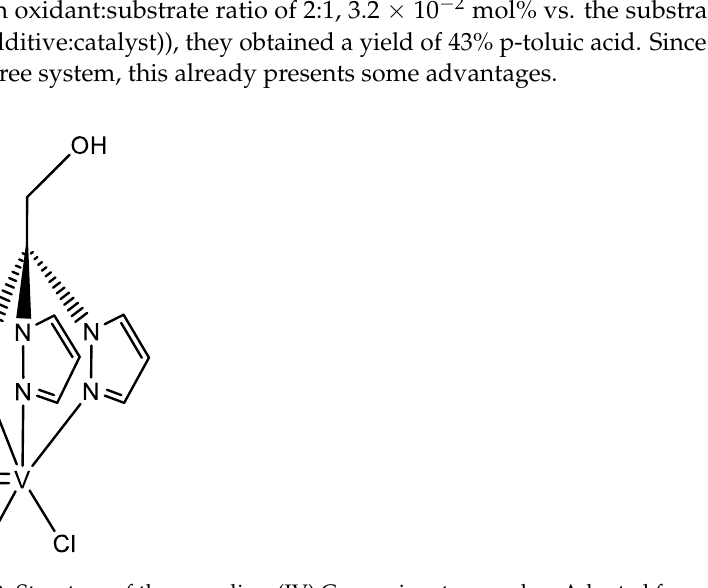
Figure 9. Structure of the vanadium(IV) C-scorpionate complex. Adapted from [43]. Samanta and Srivastava [44] explored the use of an FeVO 4 graphitic carbon nitride (g-C 3 N 4 ) nanocomposite for the oxidation of various cycloalkanes, including p- xylene. In their work, they compared catalysts using conventional heating (catalyst (50 mg), 60 ◦ C, 4 h, H 2 O 2 :substrate = 2.5) and photocatalysis (catalyst (50 mg), 20–25 ◦ C, 4 h, H 2 O 2 :substrate = 2.5, 250 W high-pressure visible lamp > 420 nm). Overall, the nanocomposite with a FeVO 4 :g-C 3 N 4 wt% of 37 was found to be more active in the conditions of the study, and for p- xylene oxidation, achieved a yield of 21.3% for 4-methyl benzaldehyde in conventional heating and 34.4% for the photocatalytic system. Although the photocatalytic sys- tem presents an improvement, it is not as remarkable as for the other substrates, where the difference between the two systems is great, achieving double or even triple the yield.